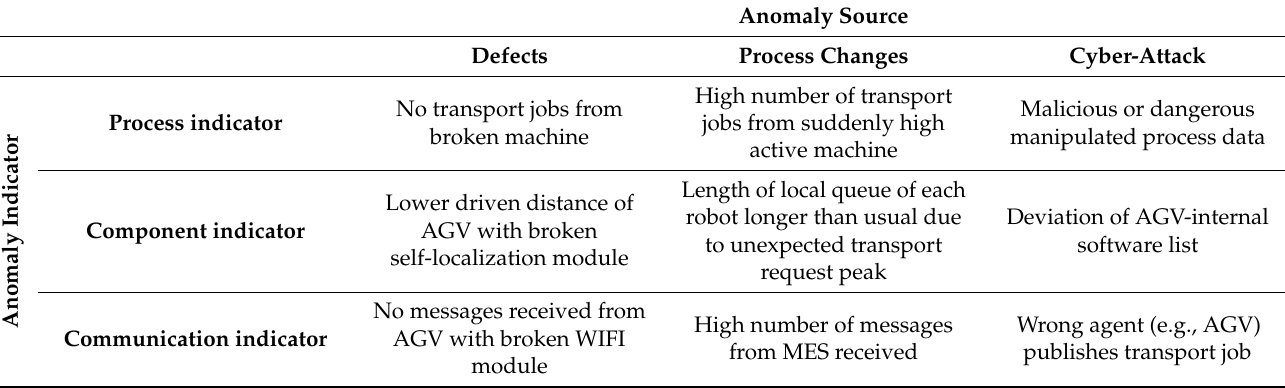
Table 1. Overview of possible anomalies classified by anomaly indicators and